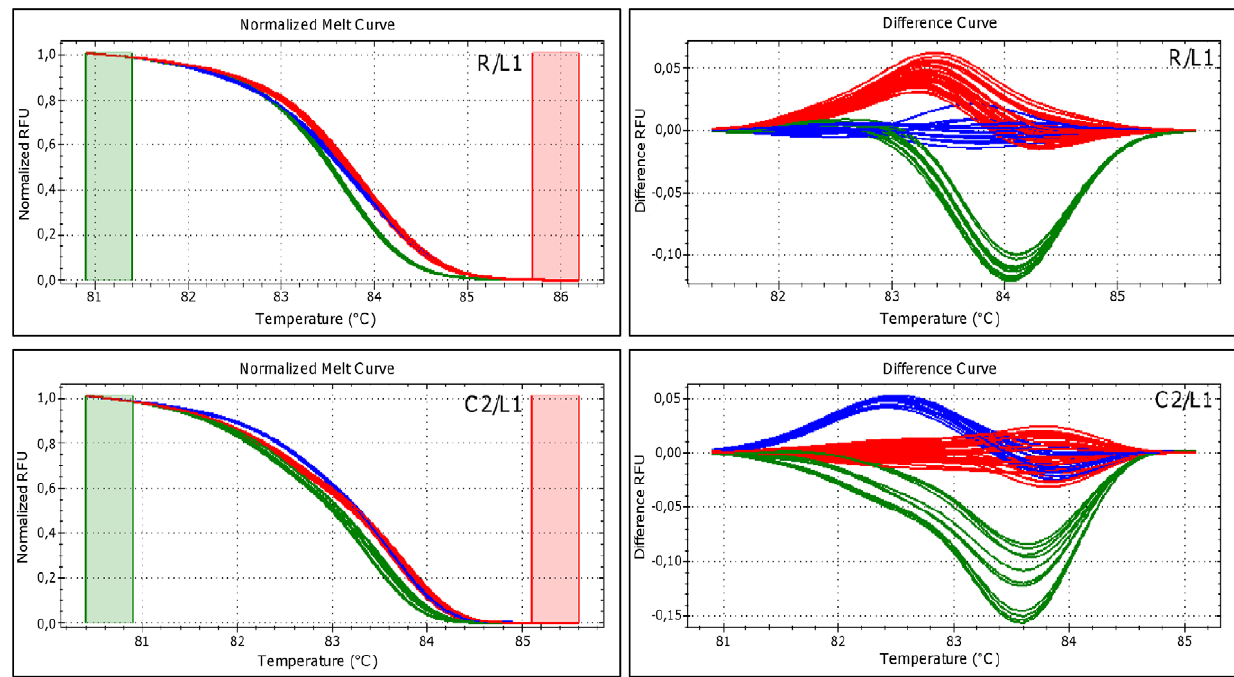
Figure 3. Discrimination of P.savastanoi pathovars by multiplex HRM analysis. Normalized and difference plots obtained in multiplex HRM assays, performed using the two couples of primer pairs for SNP markers R/L1 and C2/L1 on the 56 P. savastanoi strains examined here. On each plot different colors indicate distinct profiles, having a pathovar-specific distribution ( Psv , Psn and Psf strains, giving red, blue and green traces, respectively). RFU: Relative fluorescence units. Green and red columns represent pre- and post-melting normalization regions.